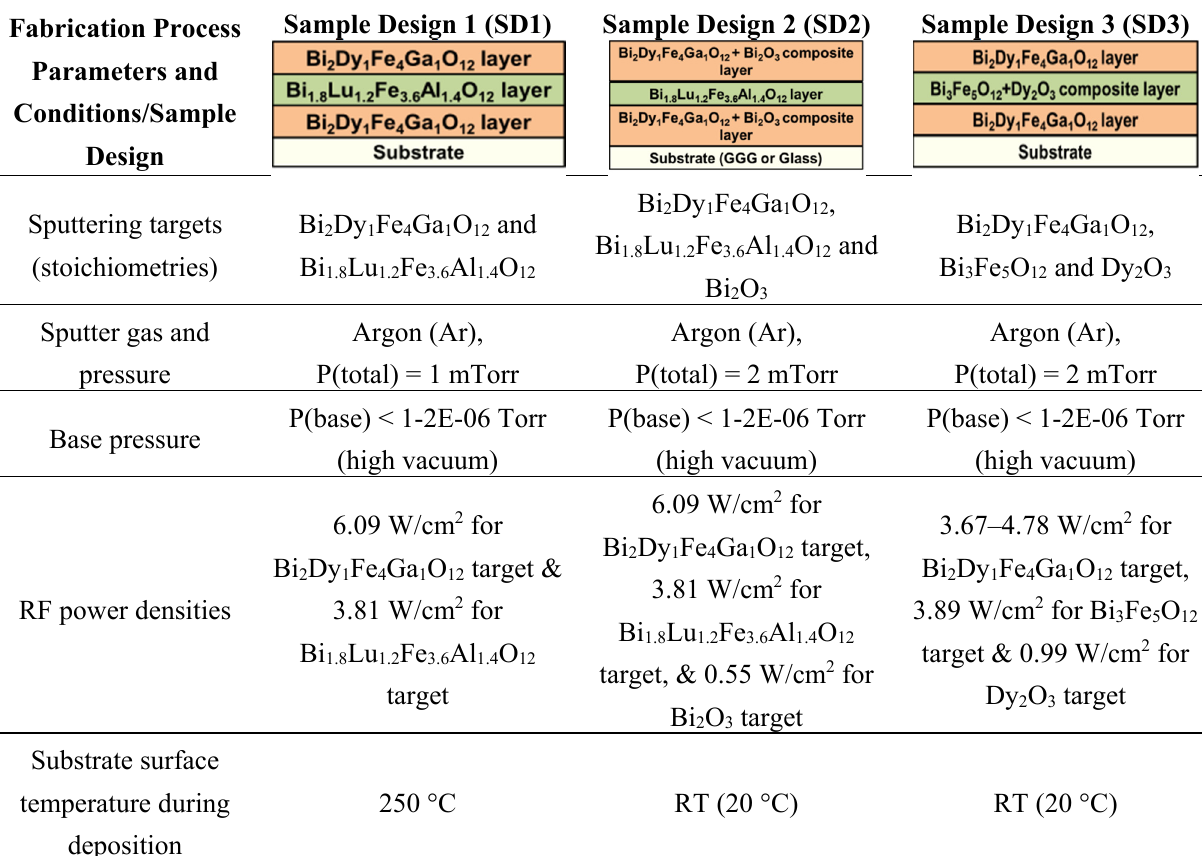
Figure 8. Schematic diagram of an exchange-coupled all-garnet trilayer structure (Substrate/Perpendicularly-magnetized garnet layer/In-plane magnetized garnet layer/ Perpendicularly-magnetized garnet layer) indicating the types of MO garnet compositions and their individual magnetization behaviors ( a ) and the expected (hybrid-type) alteration of magnetic properties (magnetization vector direction) of the all-garnet multilayer structure ( b ). Table.1. Typical sputtering conditions and process parameters used to produce all-garnet